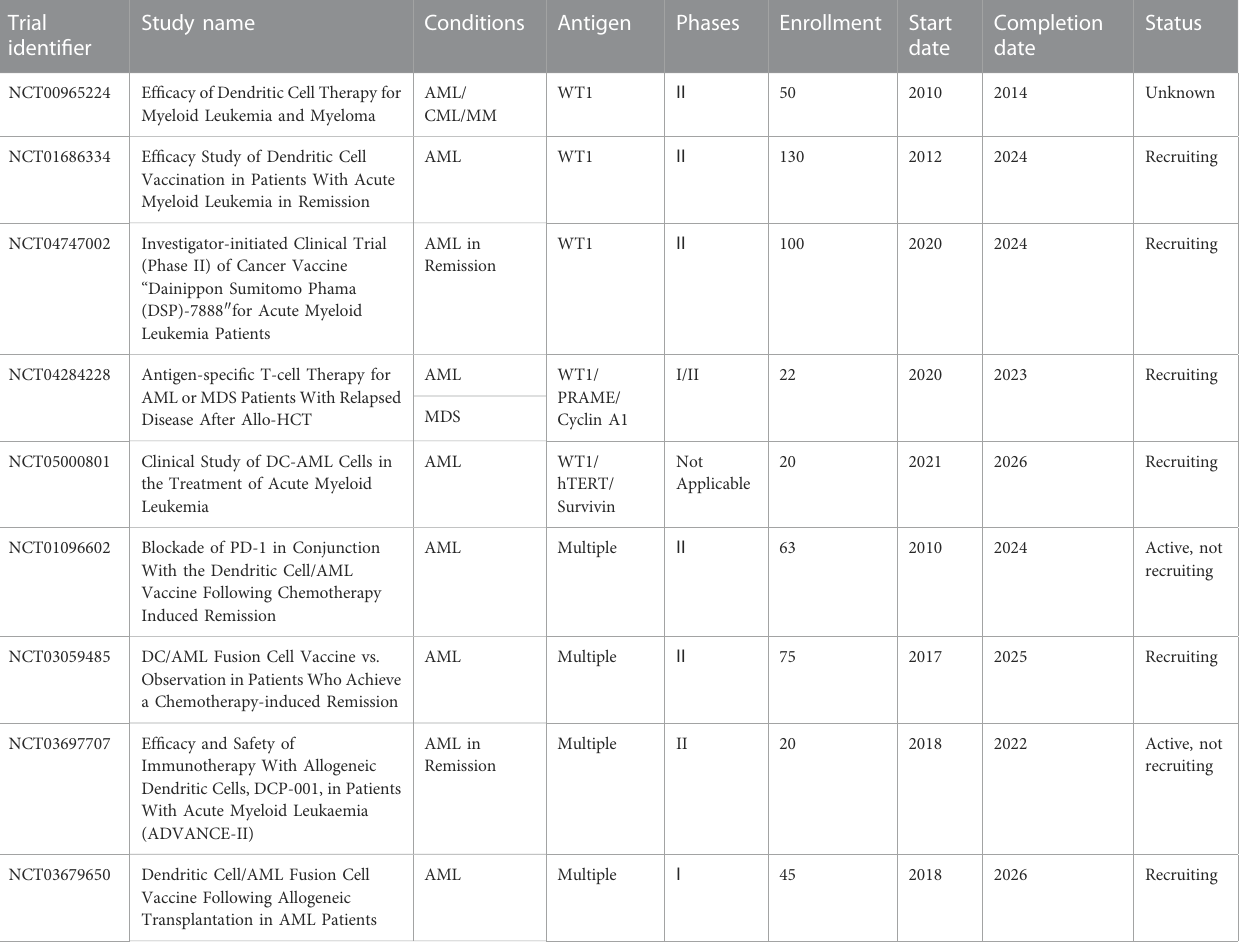
TABLE 2 Current clinical trials using dendritic cell vaccination for immunotherapy of AML. Trial identi fi